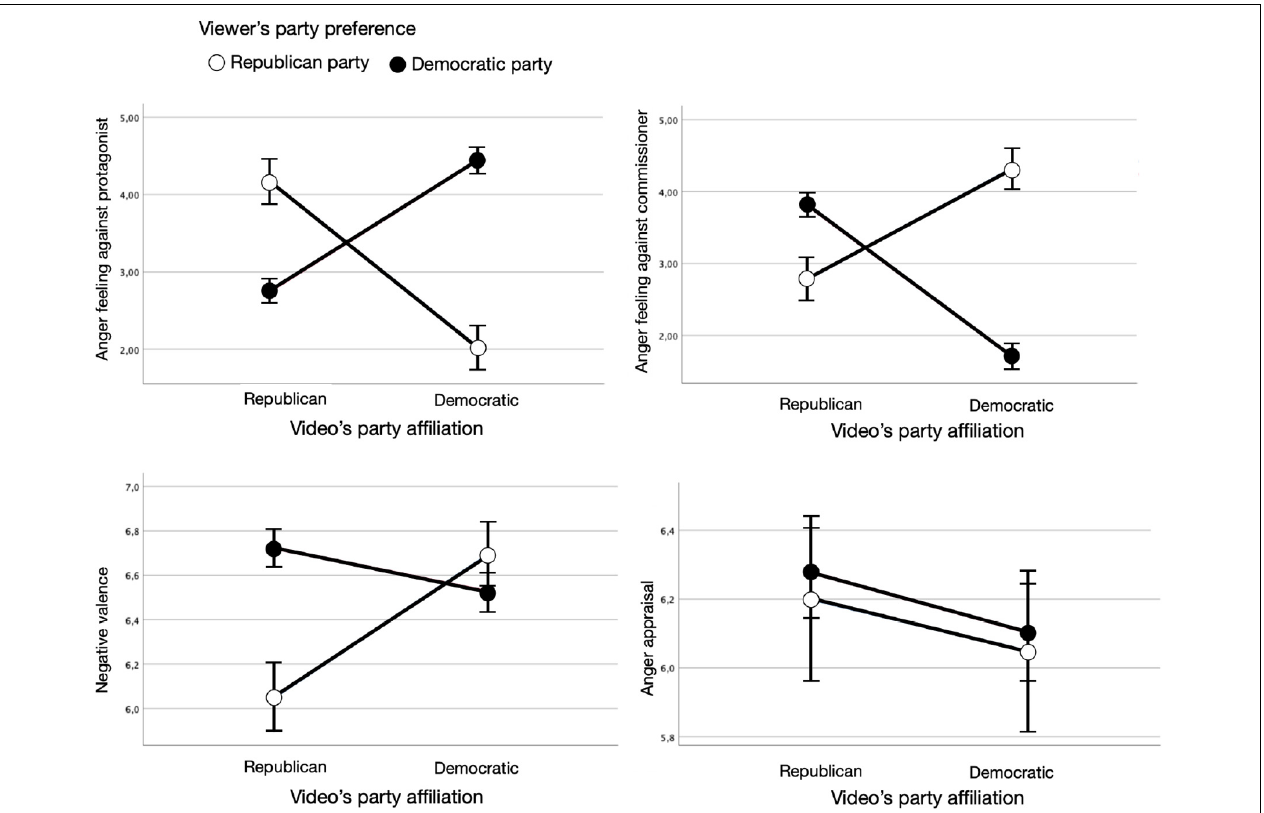
FIGURE 3 | Interaction effects of guessed party affiliation and viewer’s party preference on the four components of anger: feeling against protagonist, feeling against commissioner, negative valence, and